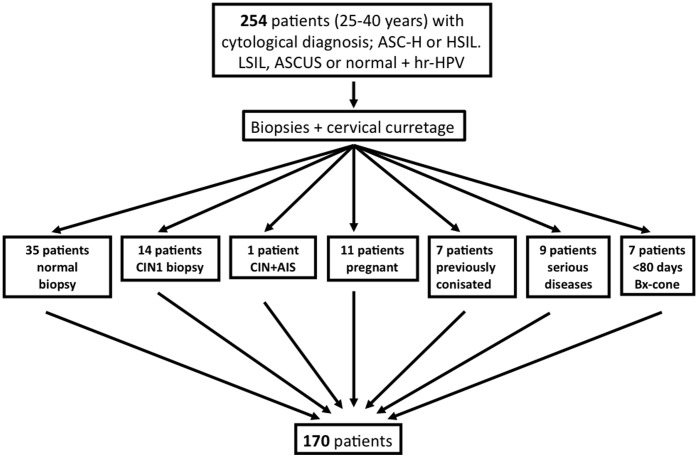
Inclusion and exclusion criteria.Norwegian guidelines for histological examination of atypical cytology were followed: 1. Low grade Squamous Intraepithelial Lesion (LSIL) + high-risk Human Papillomavirus (hr-HPV) or 2. Atypical Squamous Cells of Undetermined Significance (ASCUS) + hr-HPV or 3. Recurrences of hr-HPV positive cervical smears or 4. Atypical Squamous Cells, cannot rule out a High Grade lesion (ASC-H) or 5. High Grade Squamous Intrepithelial Lesion (HSIL). AIS denotes Adenocarcinoma in situ and Bx Biopsy.